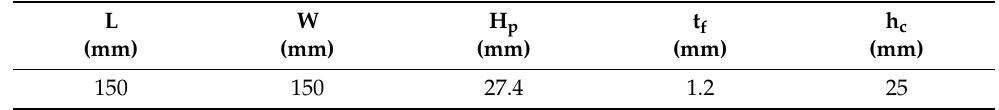
Table 2. Parameters of Nomex honeycomb sandwich